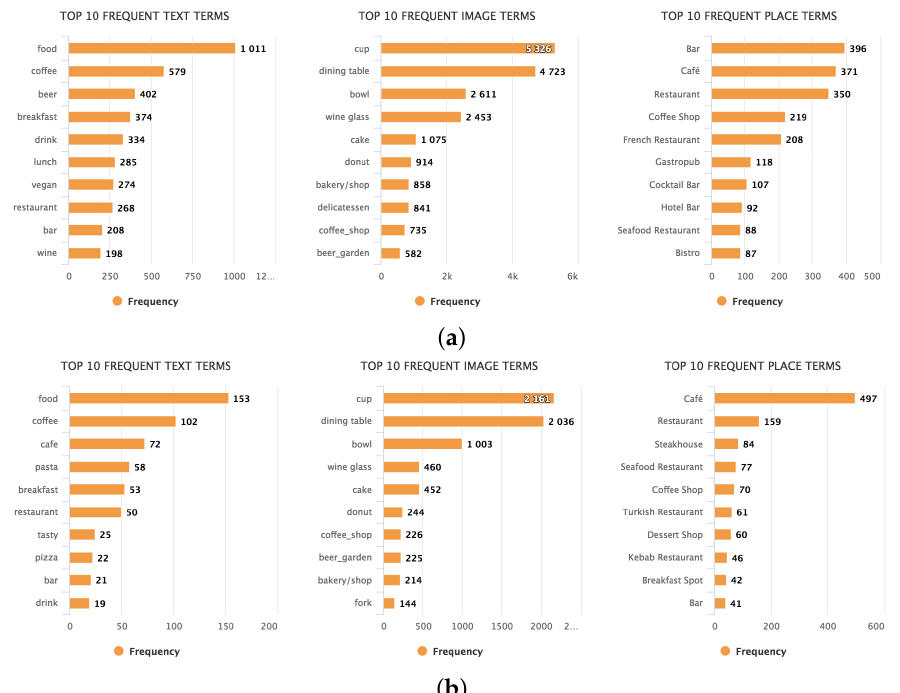
Figure 11. Bar charts visualizing the most occurring terms in social media posts classified to food consumption activities in Amsterdam ( a ) and Istanbul ( b ). For readability purposes, in the figures we show only English terms.